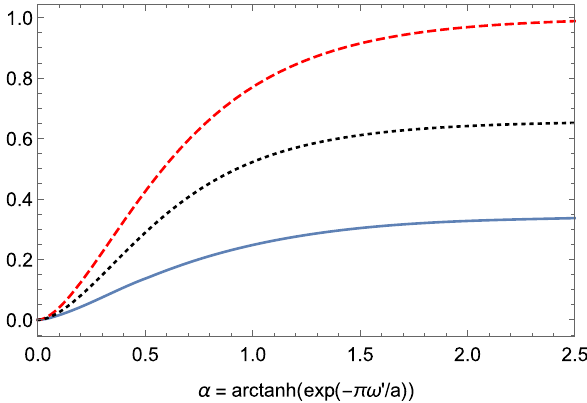
Fig. 5 State ρ M , II – Classical Correlations is the solid blue line, quan- tum discord is the black dotted line and mutual information is the red dashed